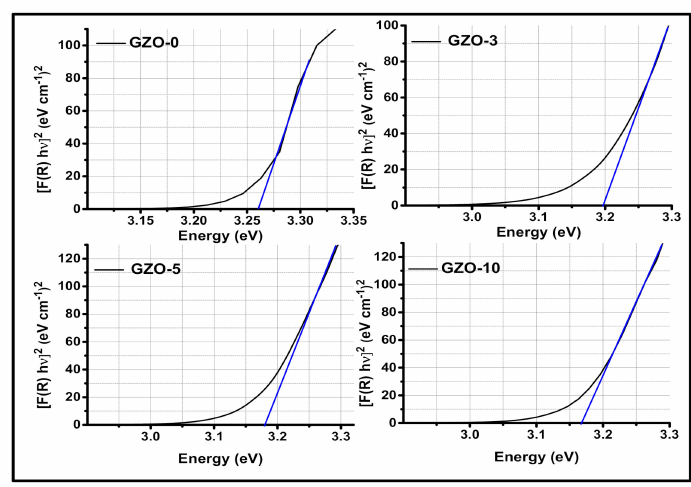
Figure 9. Plots of [ F ( R ) h ν ] 2 versus Energy = h ν for the investigated Ga-doped ZnO nanopigments.